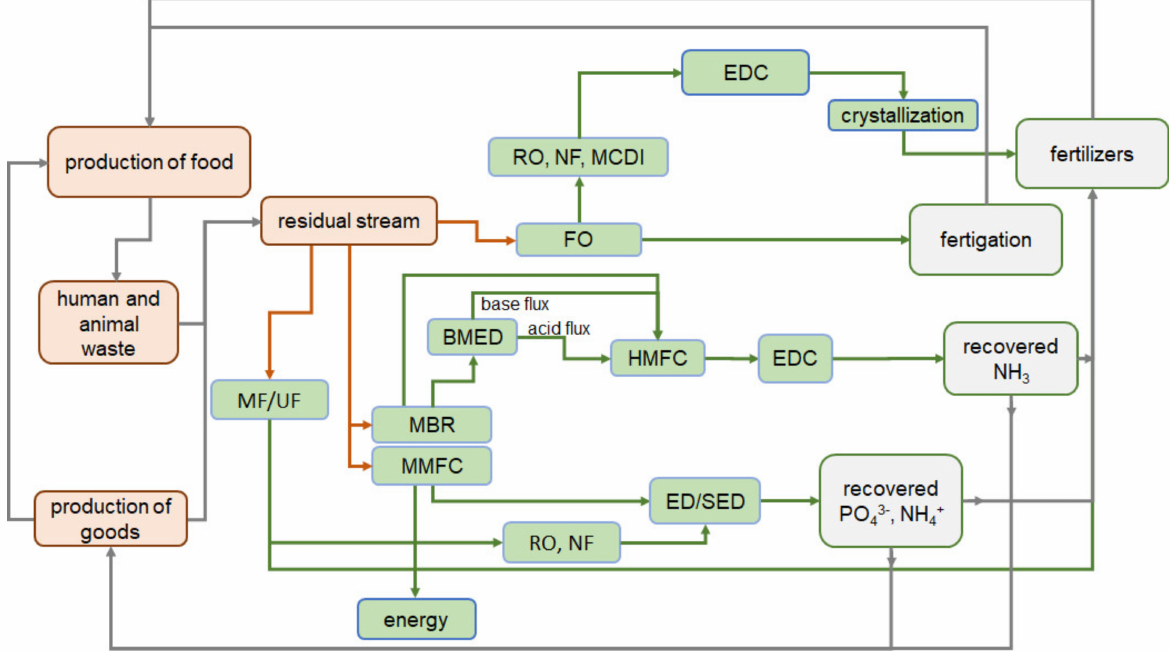
Figure 3. A scheme of some possible steps for nutrient recovery and recycling using membrane